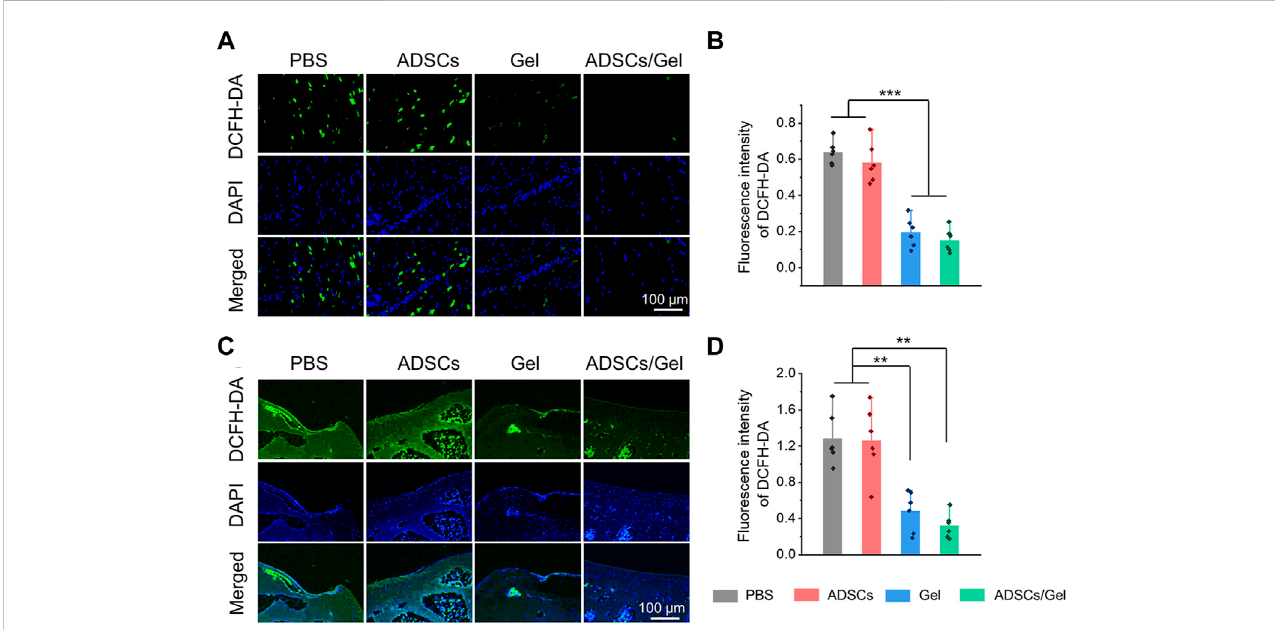
FIGURE 6 HA-EGCGhydrogelscavengingROSinthejointcavity. (A) DCFD-DAlabelingofROSlevelinsynovialtissues. (B) Quantitativeanalysisofthe fl uorescence intensity ofDCFD-DA insynovial tissues ( n =6). (C) DCFD-DA labelingofROS level in articular cartilage. (D) Quantitativeanalysis of the fl uorescence intensity of DCFD-DA in articular cartilage ( n = 6) (* p < 0.05, ** p < 0.01, and *** p <